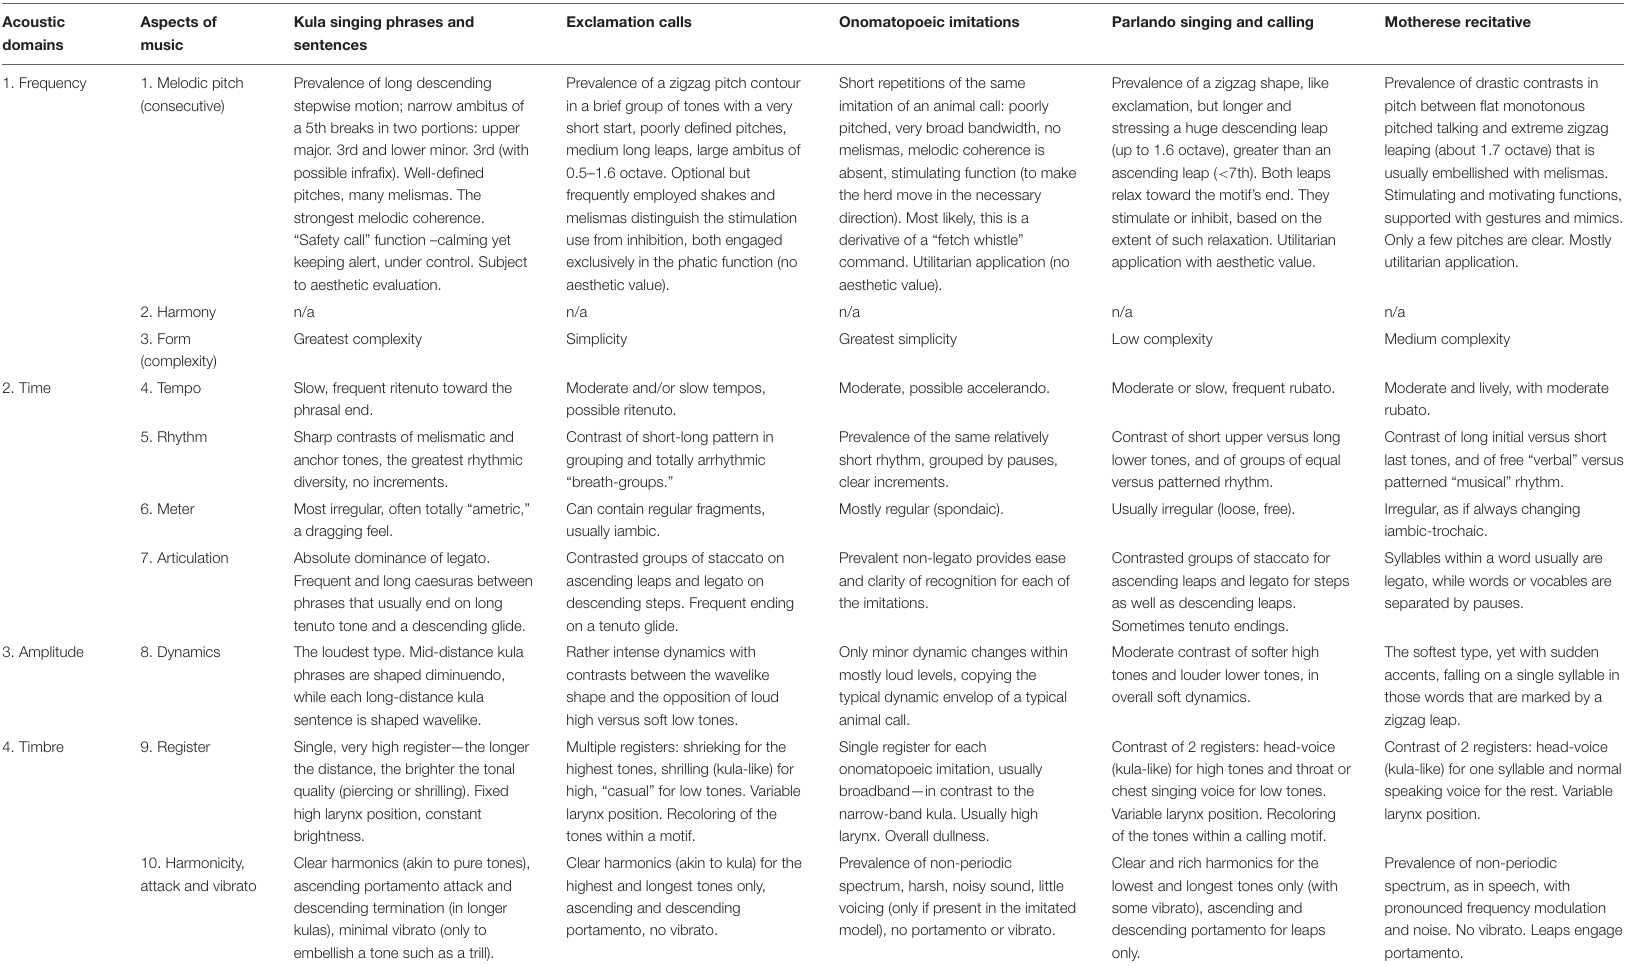
TABLE 6 | Acoustic traits of main motif types and their semantic values in kulning.